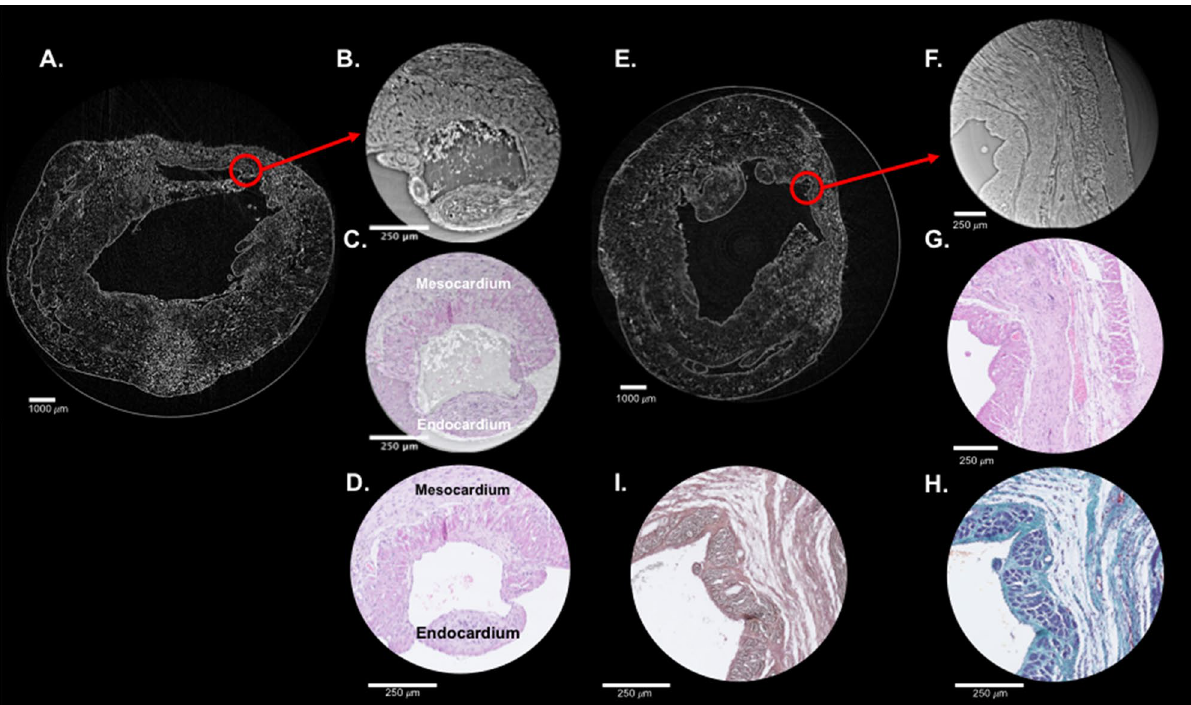
Figure 5. Comparing PB-XPCI virtual histology and conventional light microscopy. For this image one infarcted heart from a rat with induced myocardial infarction was used. Left panel-direct comparison of the identical myocardial area imaged by PB X-PCI virtual histology and light microscopy. ( A ) Low resolution PB X-PCI of the infarcted heart. Red circle indicates part of the infarcted area that was imaged by high resolution PB X-PCI. ( B ) High resolution PB X-PCI image of the selected area. ( C ) Overlap of the approximately same slice by PB X-PCI and light microscopy. ( D ) Hematoxylin and eosin-stained light microscopy. On every image from ( B ) to ( D ), a varying orientation of cardiomyocytes aggregates may be observed-at endocardial side longitudinally oriented; while towards the mesocardium are circumferentially oriented. Right panel ( E ) PB X-PCI image at low resolution representing the short axis view of the left ventricle and indicating the region of interest used for acquisition of the high-resolution PB X-PCI showed on ( F ). ( G ) Hematoxylin and eosin staining of the identical region of the same heart showing high resemblance to PB X-PCI virtual histology image. ( H ) Mallory’s trichrome staining showing increased amounts of mature collagen (shown in blue color) in the area of myocardial infarction, i.e. scar tissue. ( I ) Gömöri’s silver impregnation staining showing no reticular fibers in the region of interest (no areas stained in black on the